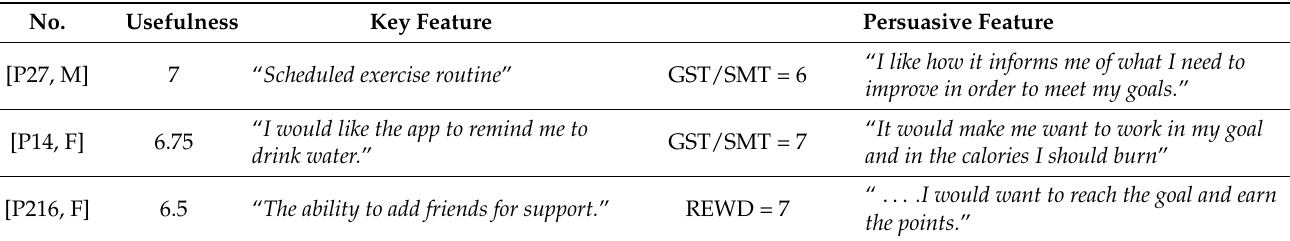
Sample comments on the relationship between perceived usefulness and receptiveness to persuasive